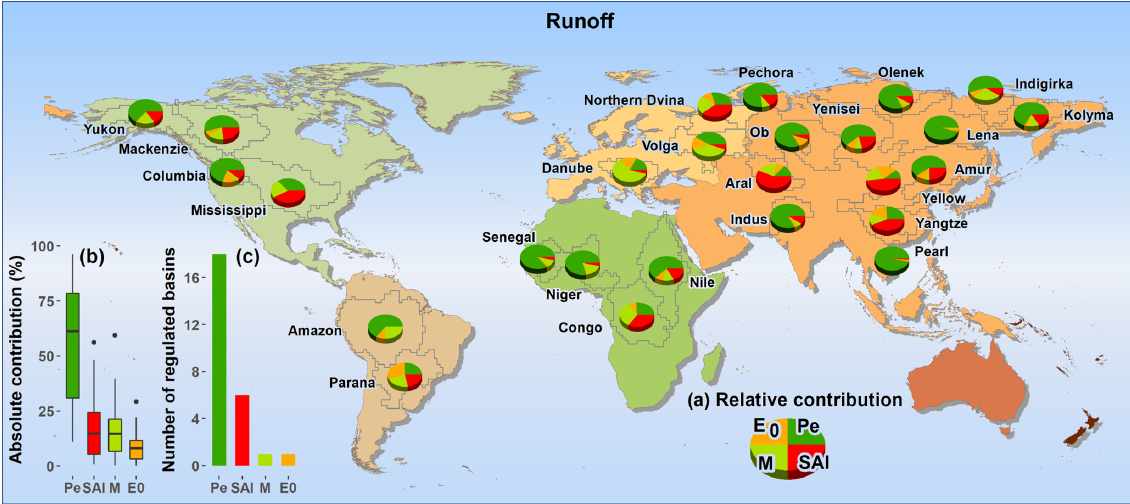
Figure 8. Absolute value of contributions to the long-term mean changes in runoff (before and after change point of R ) from P e , SAI, M and E 0 changes. The distribution ranges of absolute values of contribution for each factor are shown in (b) and the number of basins dominated by each factor with the largest relative contribution is summarized in (c)